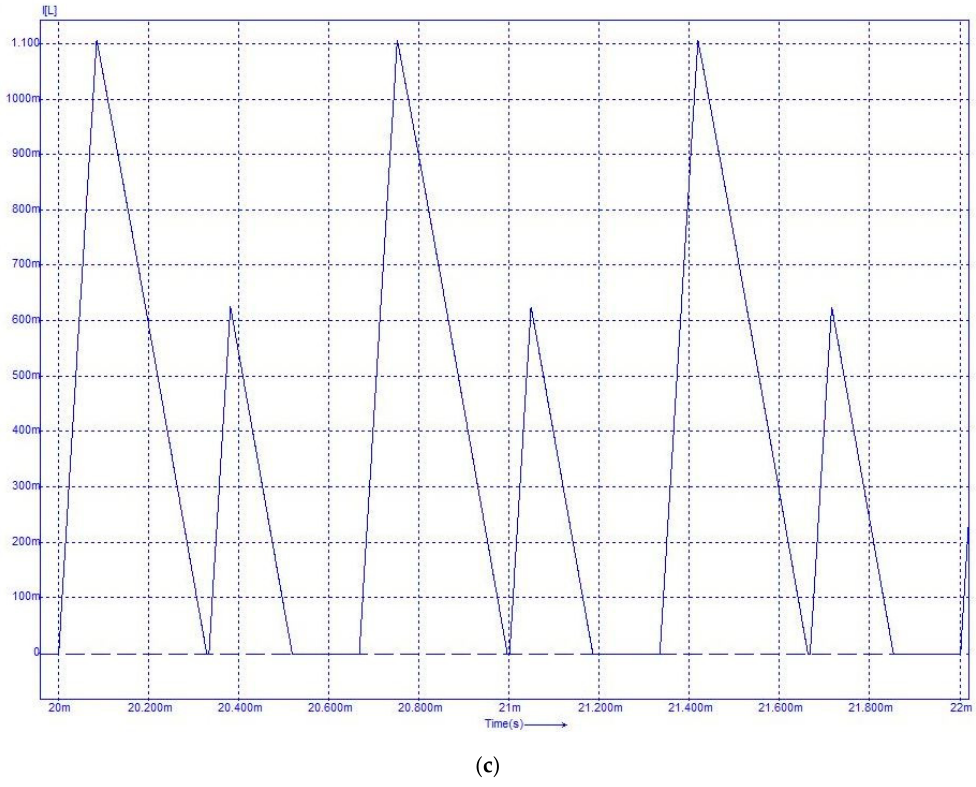
Figure 7. ( a ) The inductor current waveform for k = 1.1. The horizontal dotted line denotes the zero level and the solid line the inductor current. ( b ) Phase portrait for stable operation, k = 1.1. ( c ) Inductor current for parameter k = 1.2, higher than bifurcation threshold value of 1.1589. Unstable operation with period doubling (period 2 subharmonic) is obvious.